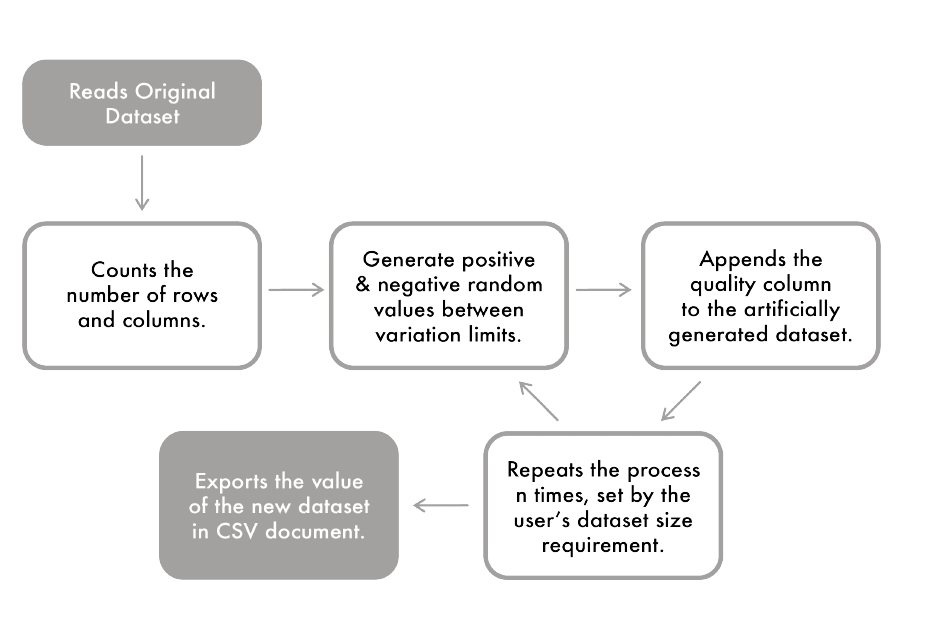
Figure 5. Data Augmentation proceedings.